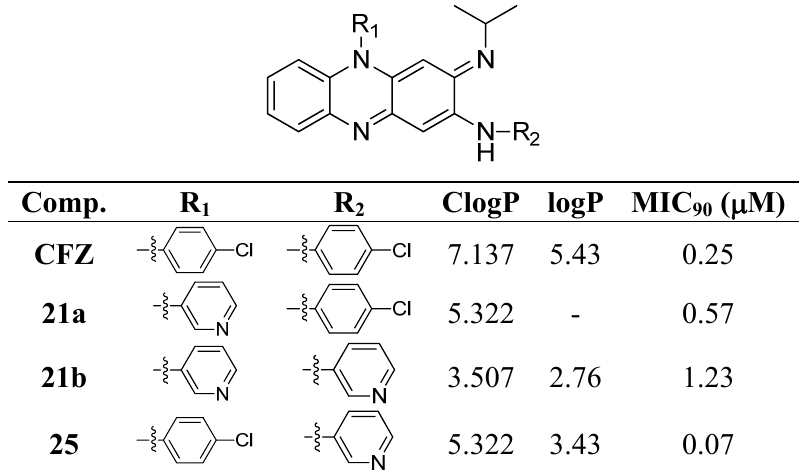
Table 2. Riminophenazines with R against M. tuberculosis H